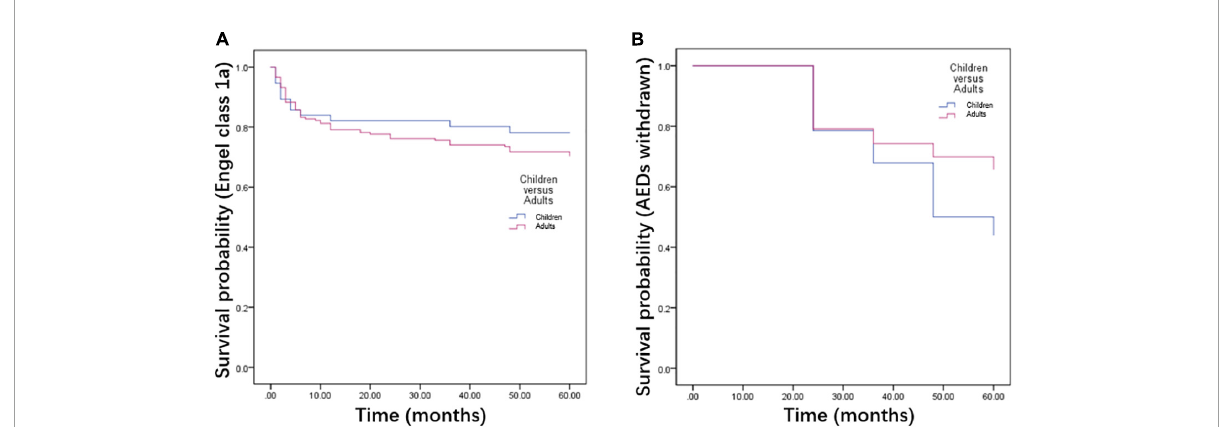
FIGURE3 Kaplan-Meier survival curves of children and adults with temporal lobe epilepsy (TLE). There was no significant difference in seizure recurrence between TLE children and adults (A) . The TLE adults experienced a lower probability of antiepileptic drugs (AEDs) withdrawal than TLE children after surgery (B) .